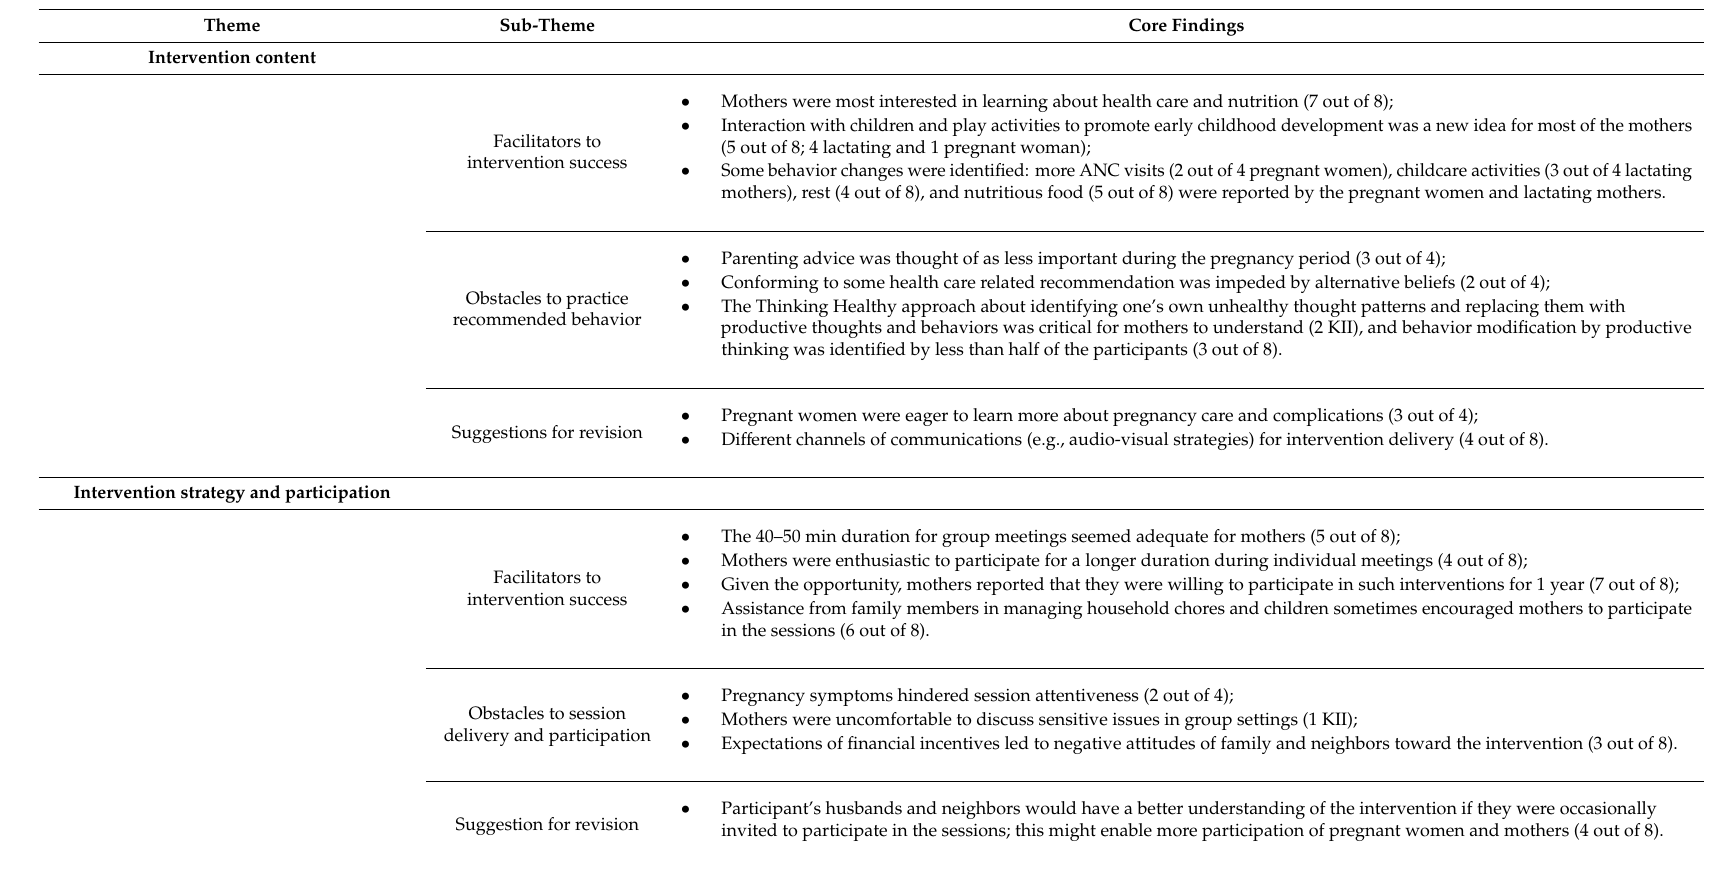
Table 6. Thematic model of intervention facilitators and